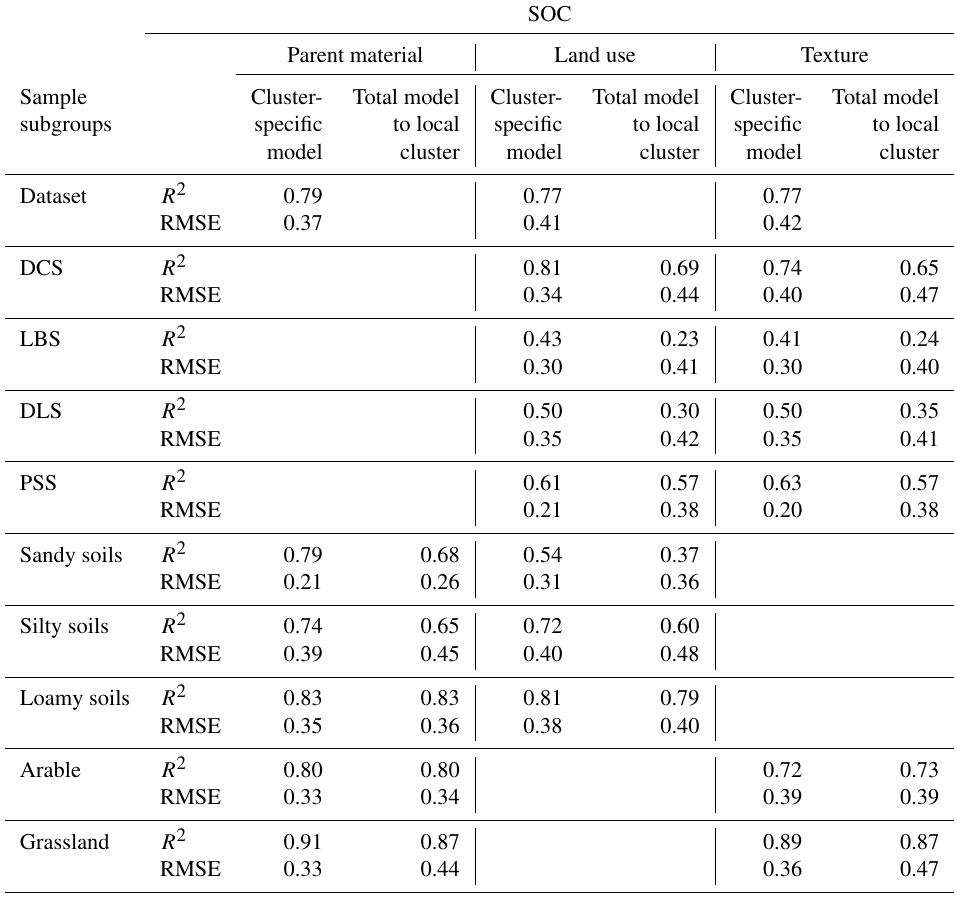
Table 6. R 2 and RMSE for implementation of the model for the total dataset in local clusters to estimate